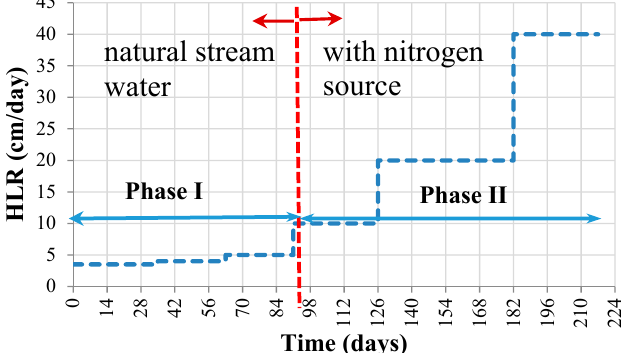
Figure 5. Sequence of water application in VSSF and HSSF wetland units. HLR: hydraulic loading rate.